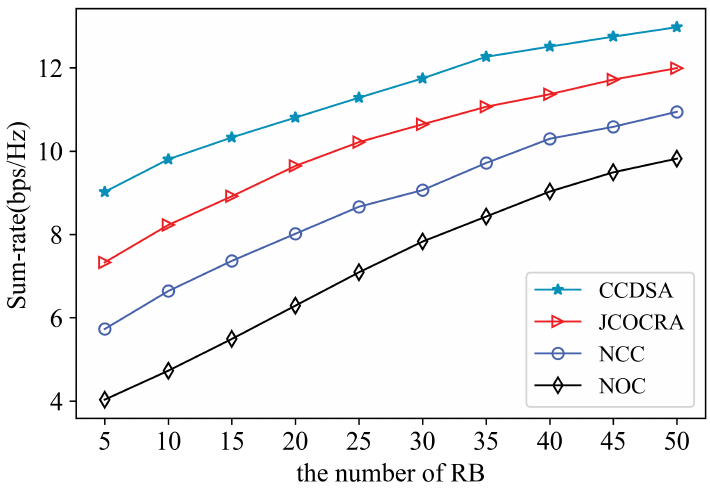
Figure 7. Sum-rate comparison of different scheme under different numbers of RB